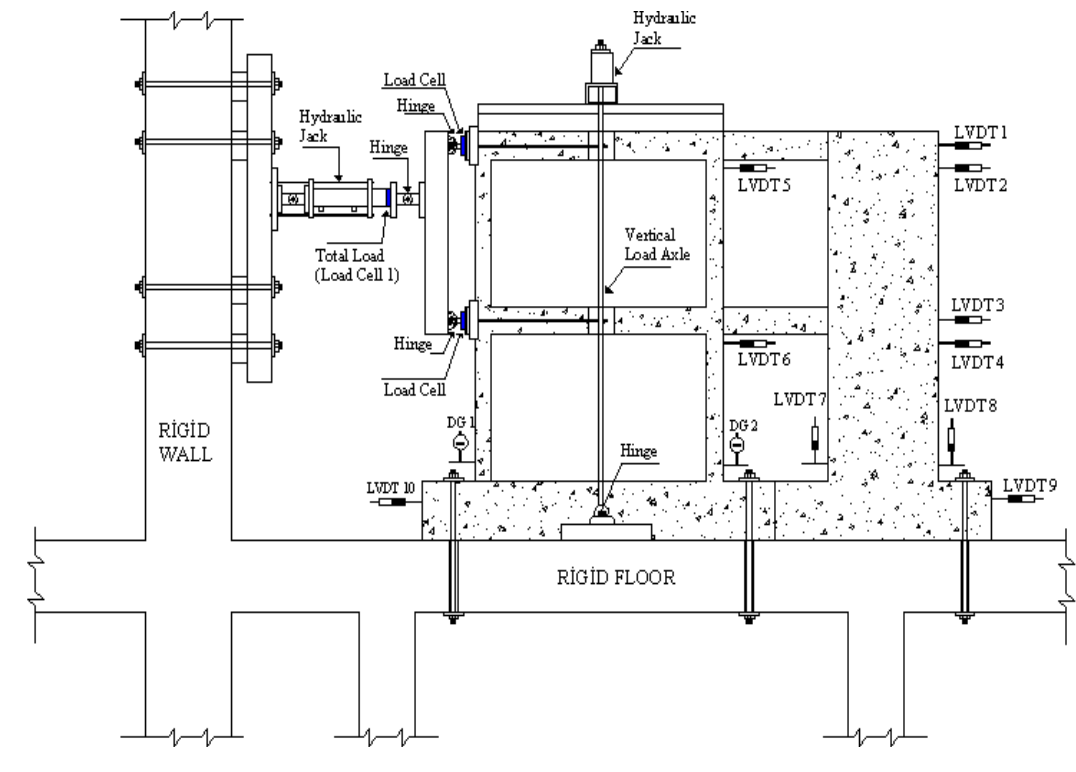
Fig. 7. Loading system of the 2nd group tests (G 2 -S 3 ) (Ozturk, 2010). Figure 7. Loading system of the 2 nd group tests (G